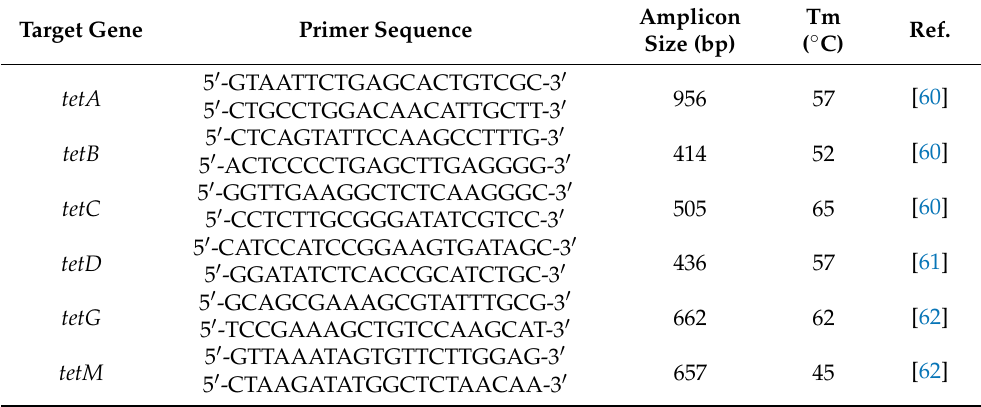
Table 3. Primer and amplicon features of PCR assays used for tet gene characterization. Target